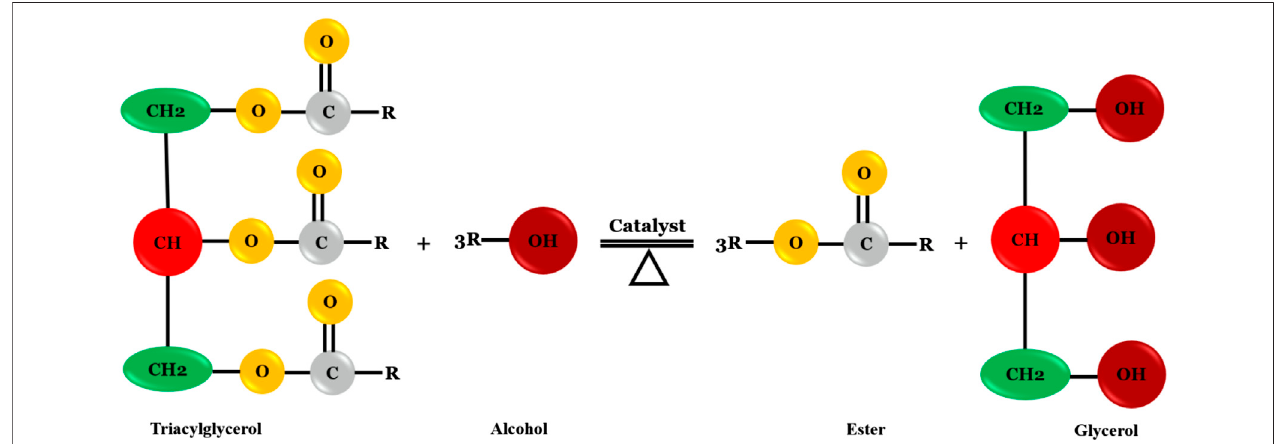
FIGURE 1 | Typical transesteri fi cation reaction to produce biodiesel (Mo fi jur et al., 2020b).